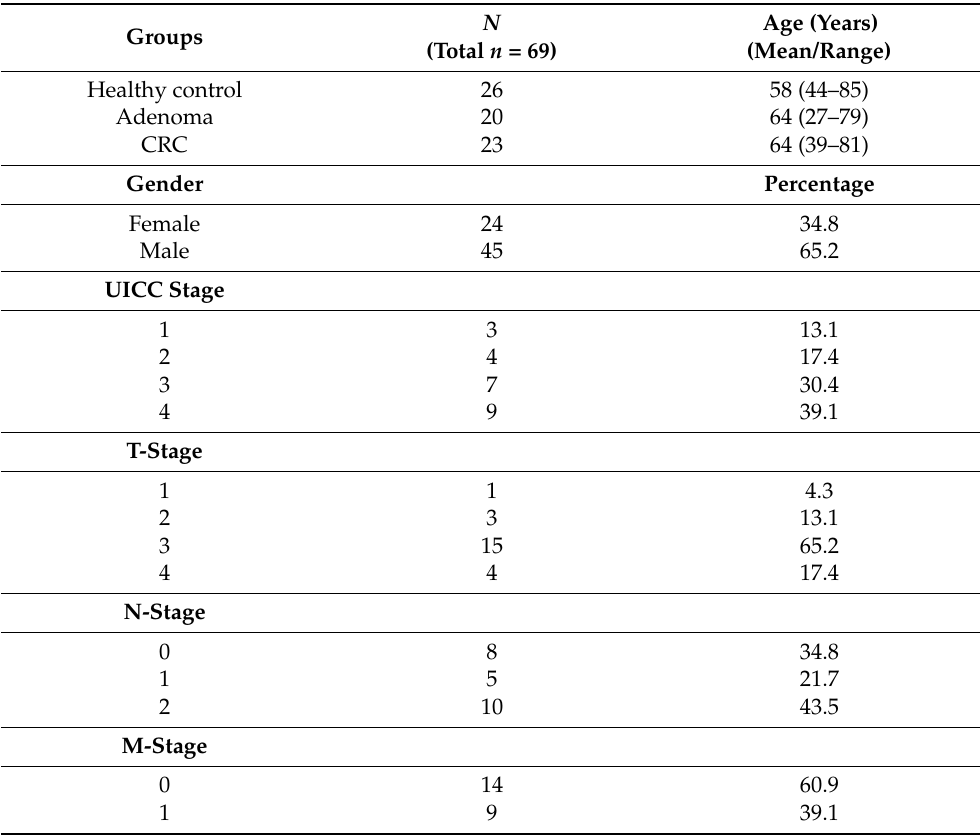
Table 1. Details of patients included in this